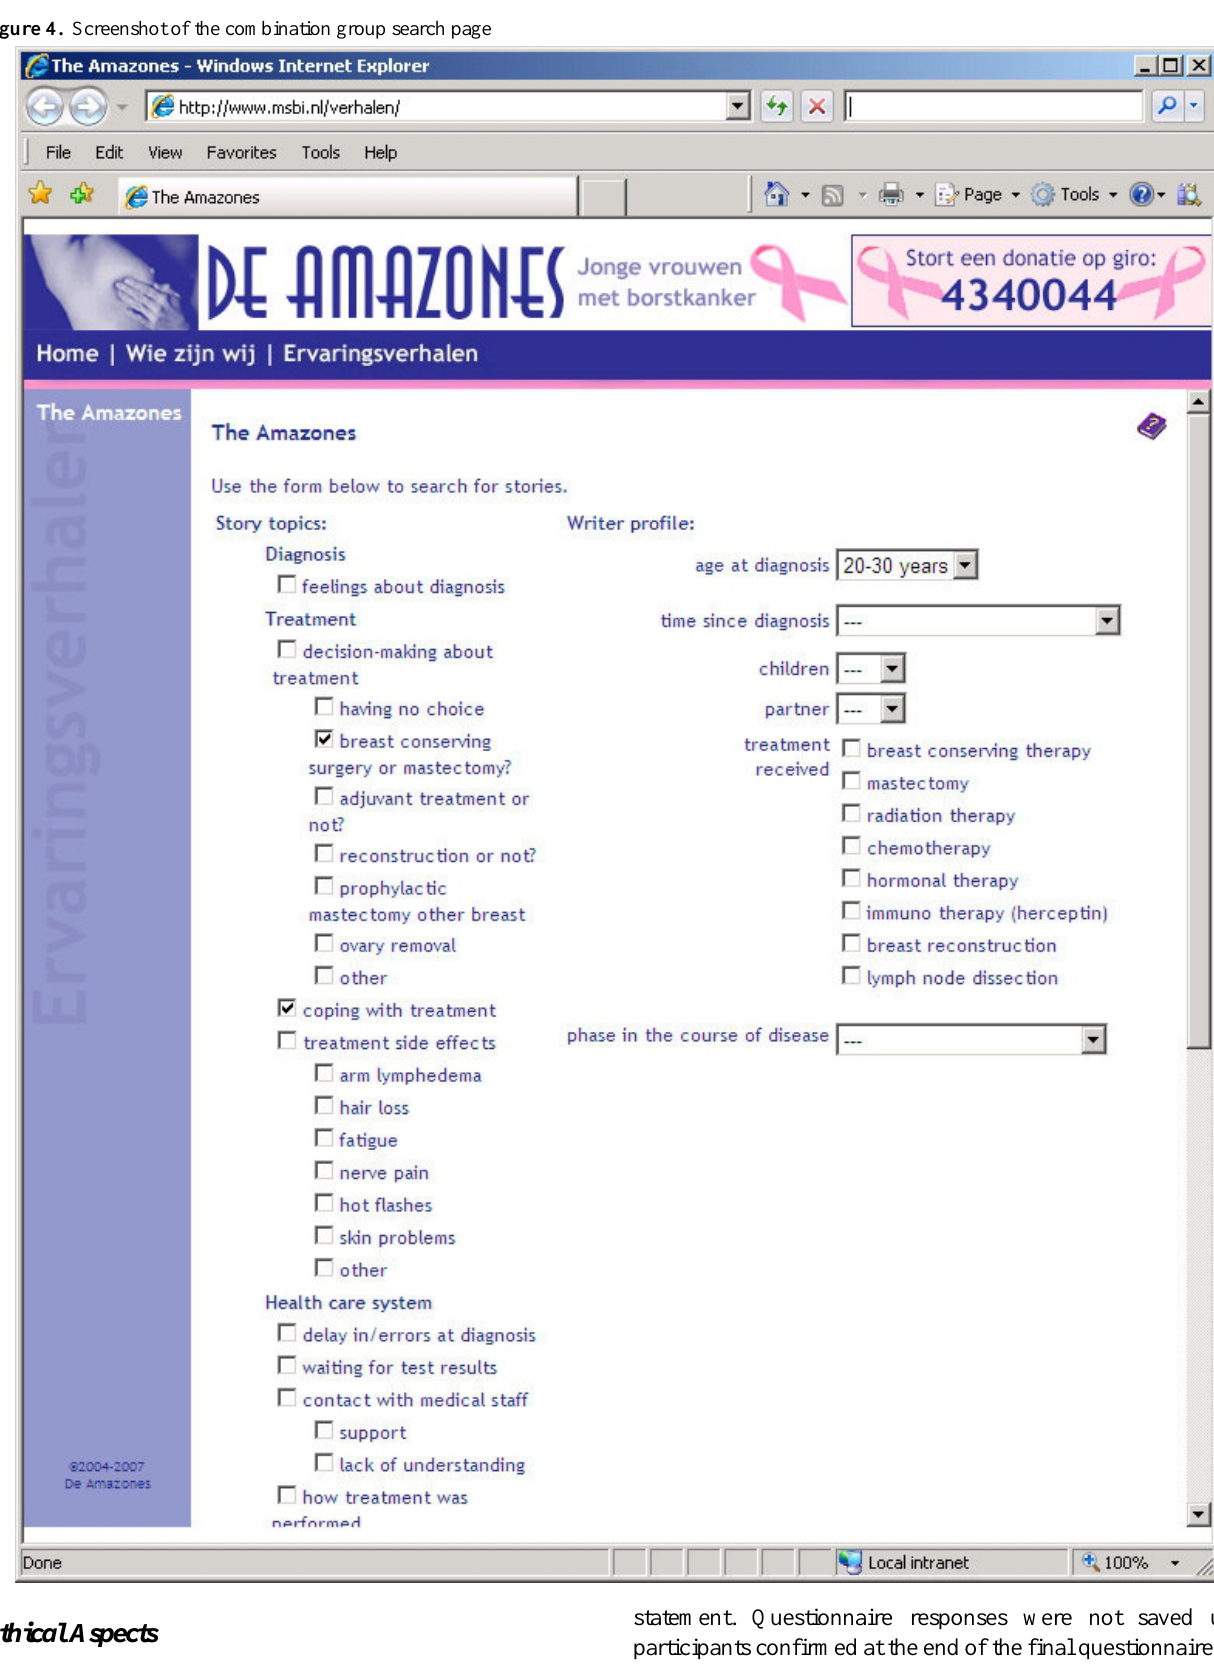
Figure 4. Screenshot of the combination group search